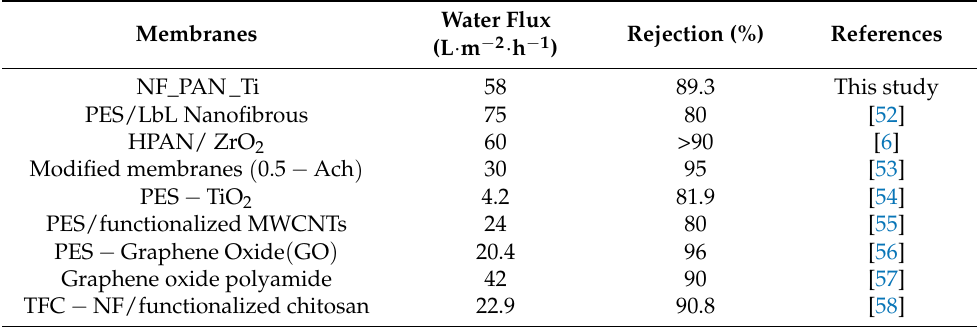
Table 4. Synthesized membrane water flux and rejection performance in this study and some earlier reported ones.